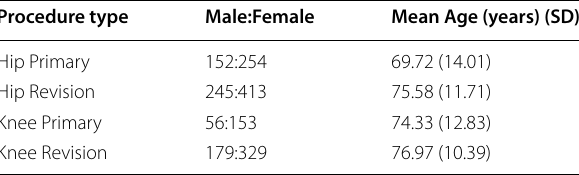
Table 1 Patient demographics by procedure type Procedure